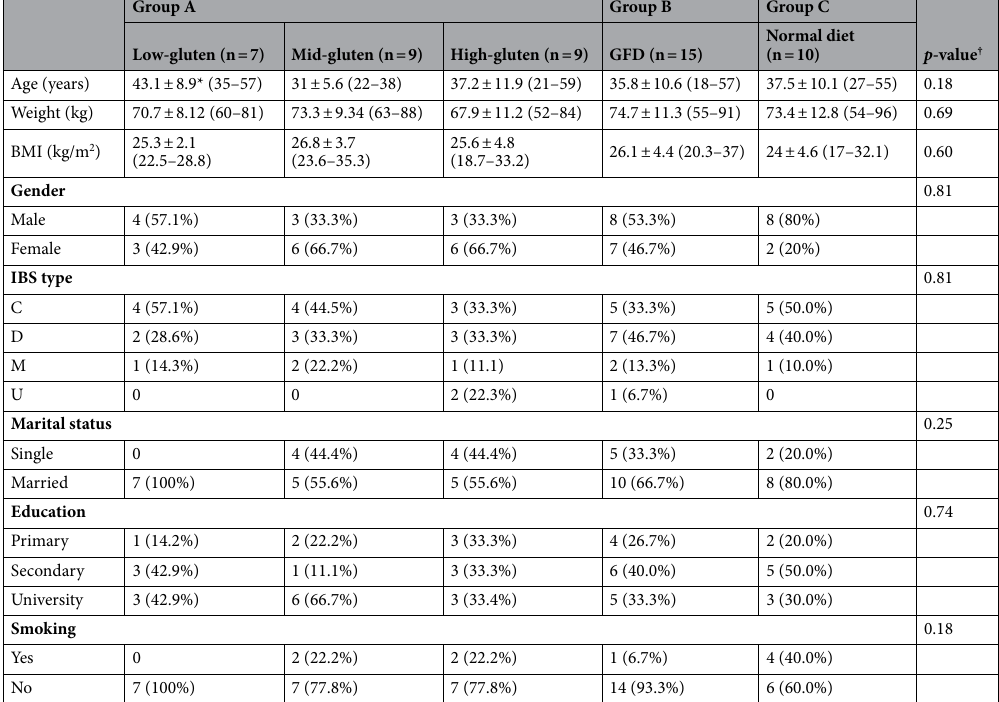
Table 1. Baseline characteristics of participants with irritable bowel syndrome (IBS) before intervention. Group A: Patients receiving special bread containing 8 g/day gluten for 2 weeks; gluten-tolerating subjects received 16 g/day for 2 weeks and then 32 g/day for a further 2 weeks. Group B: Patients following a low- FODMAP strict GFD for 6 weeks. Group C: Patients receiving a regular gluten-containing diet for 6 weeks. IBS type: IBS-C (constipation), IBS-D (diarrhea), IBS-M (mixed) and IBS-U (unsubtyped). *Mean ± standard deviation (min–max). † Using the Kruskal–Wallis test for numeric data and the chi-square test for categorical data.